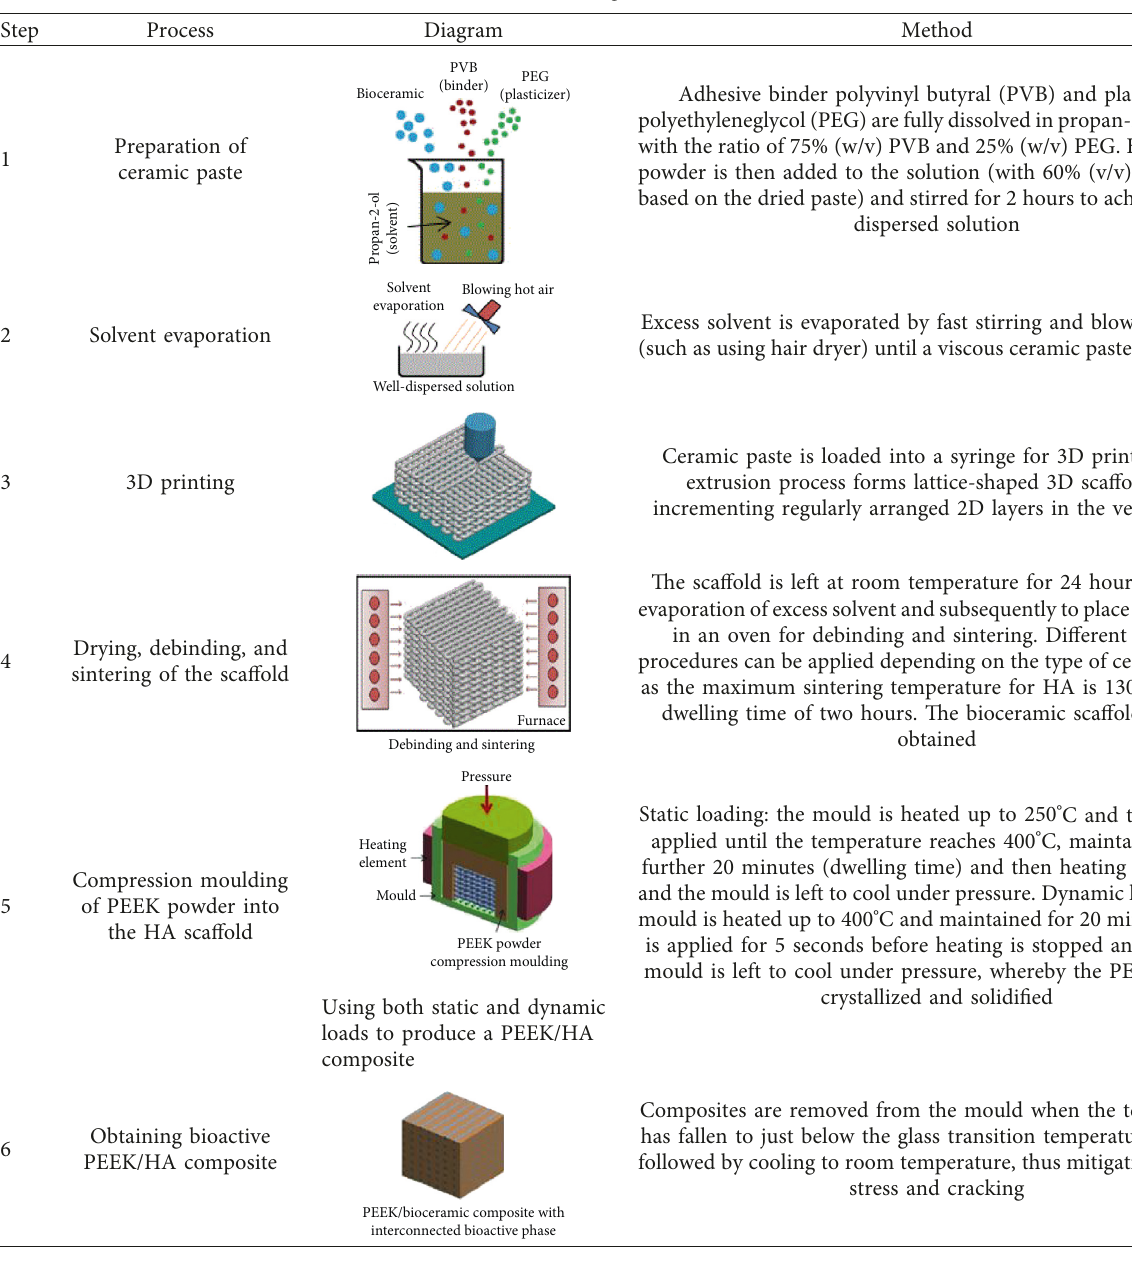
Table 2: The method for fabricating bioactive PEEK/HA bone